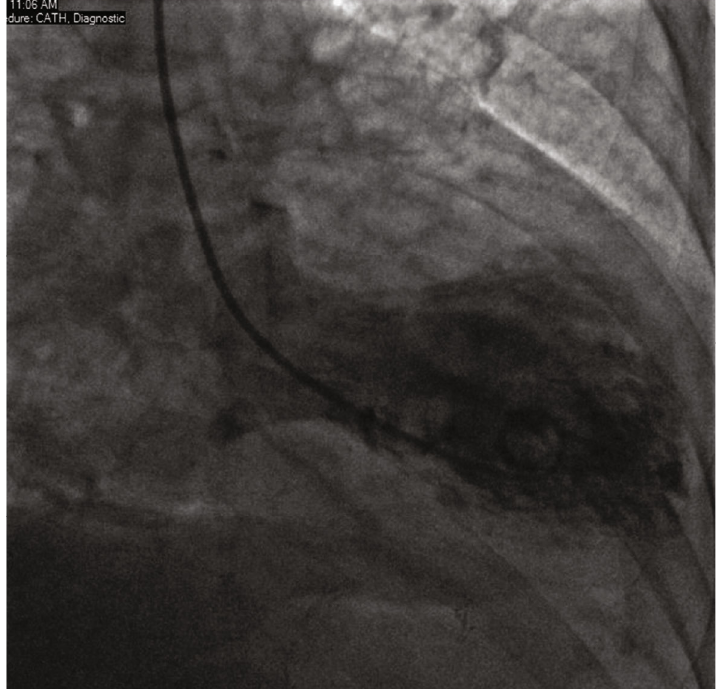
Figure 4: Left ventriculogram in